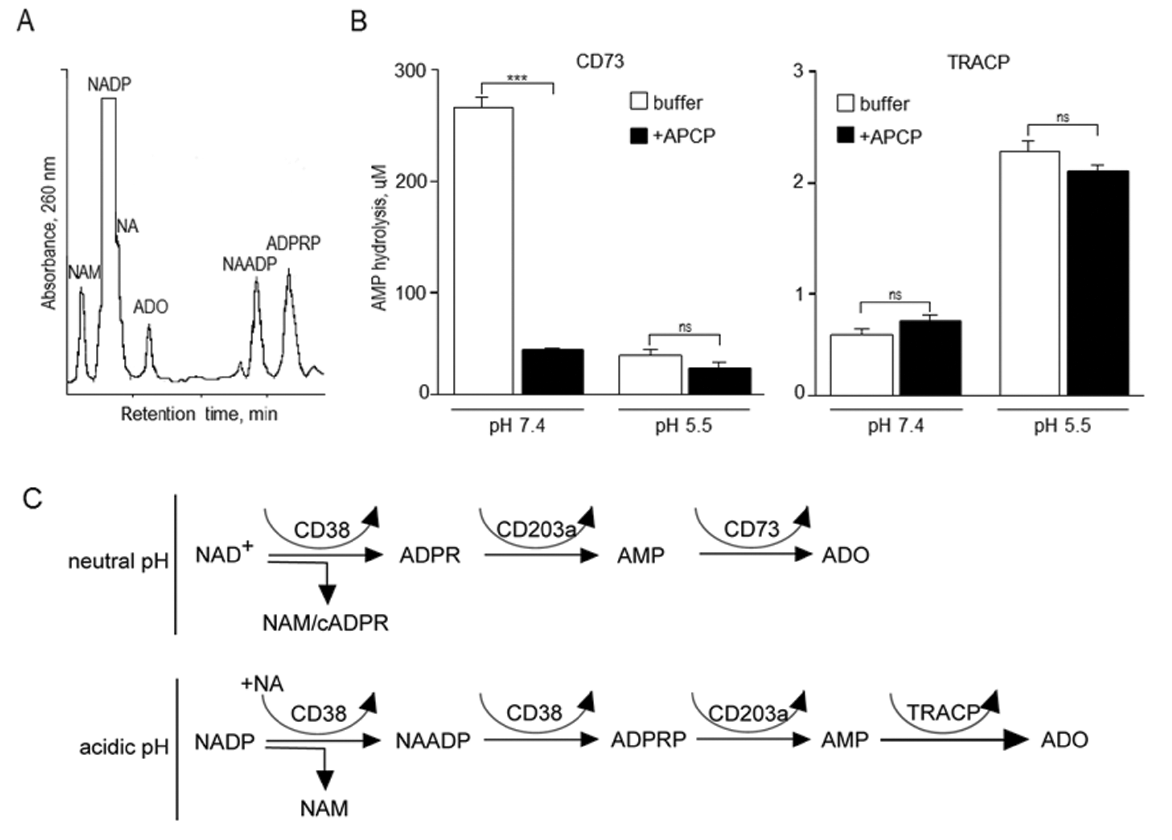
the BM niche, exploiting the machinery normally used to generate tolerance